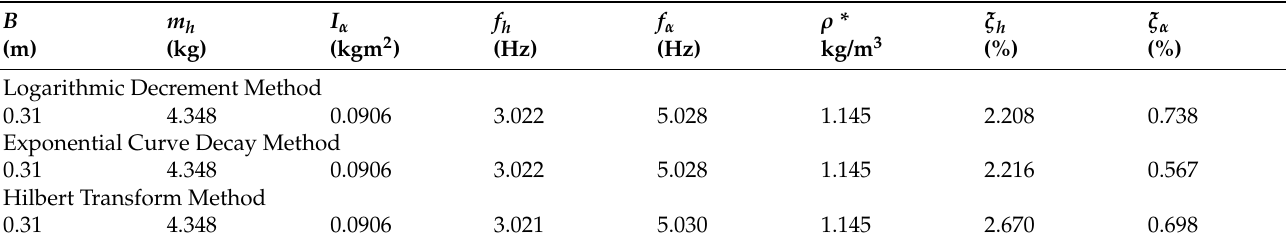
Table 2. Experimental parameters for wind-off case from SDOF test.